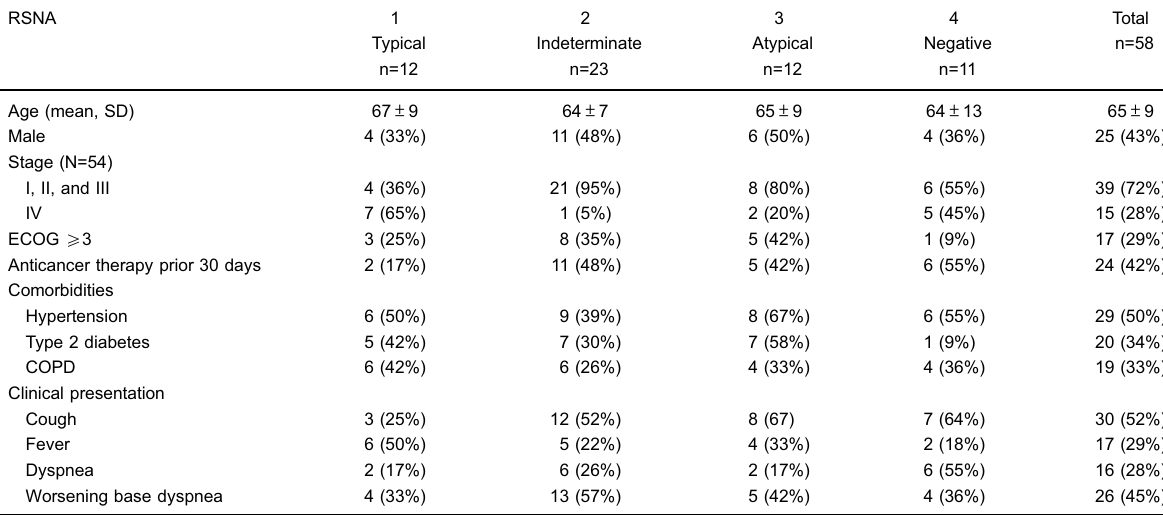
Table 1. Patient characteristics according to computed tomography (CT) fi ndings and Radiological Society of North America (RSNA) categories (1 to 4).